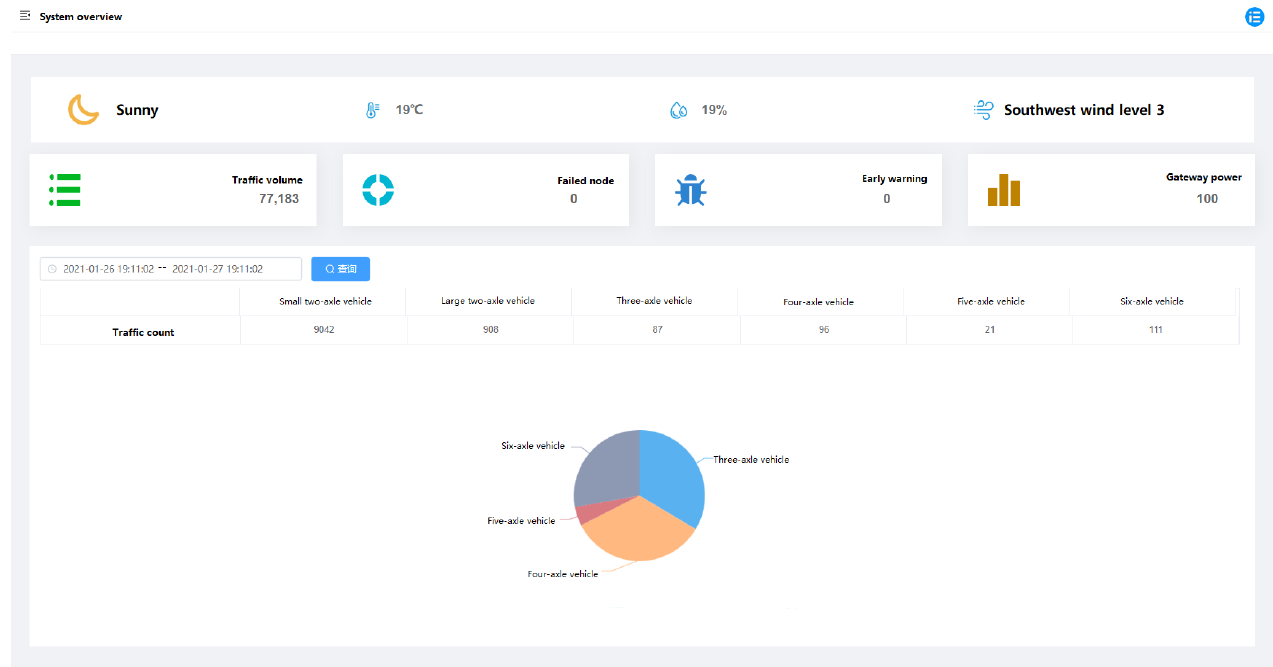
Figure 12. Website